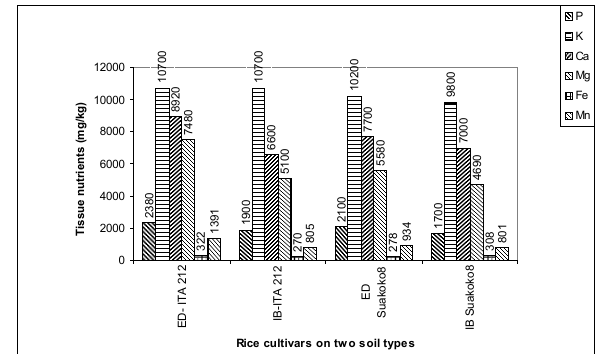
Fig 2. Tissue nutrient contents in two rice cultivars on two soil types Fig. 2. Tissue nutrient contents in two rice cultivars on two soil